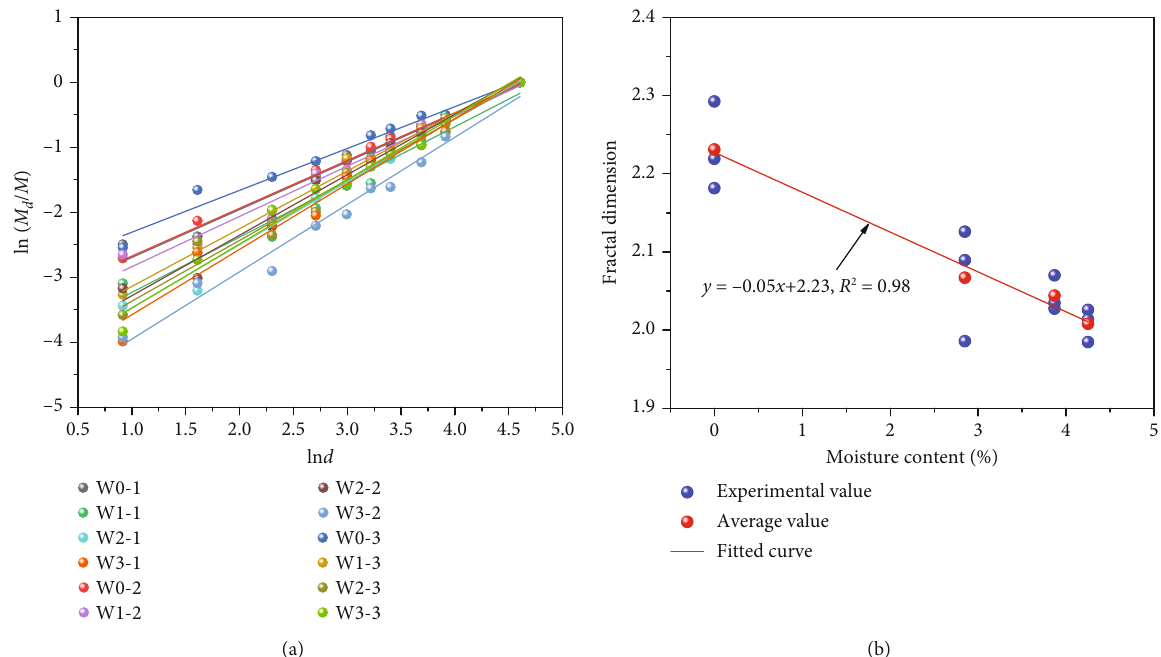
Figure 13: Calculation of fractal dimension. (a) ln x − ln ð M content.